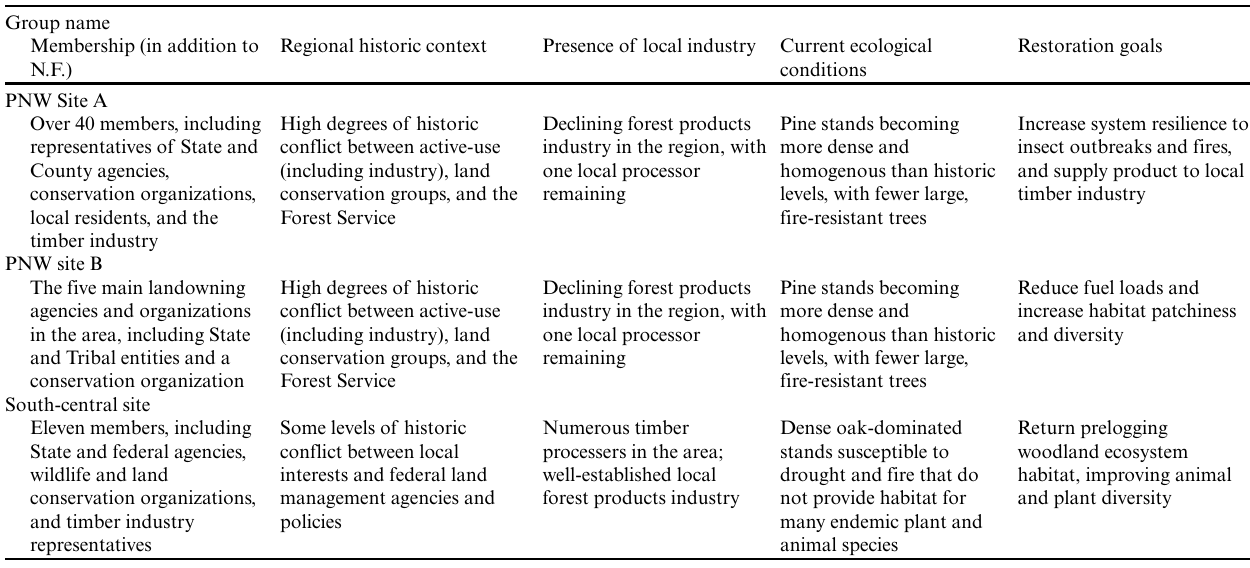
Table 1. Background information of study sites. (Information provided in program proposals.) Group name Membership (in addition to